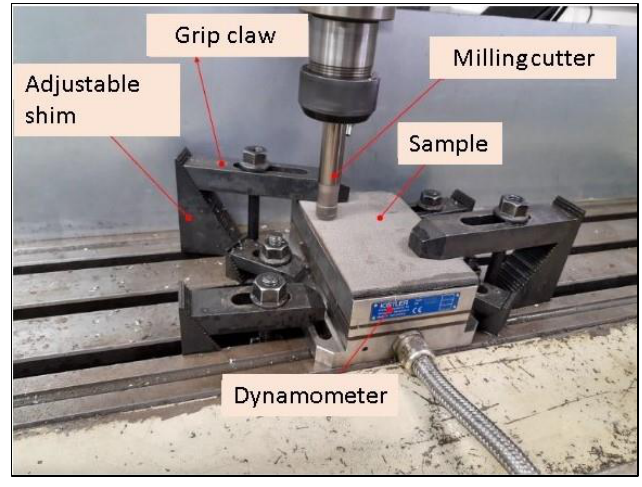
Figure 3: Assembly of